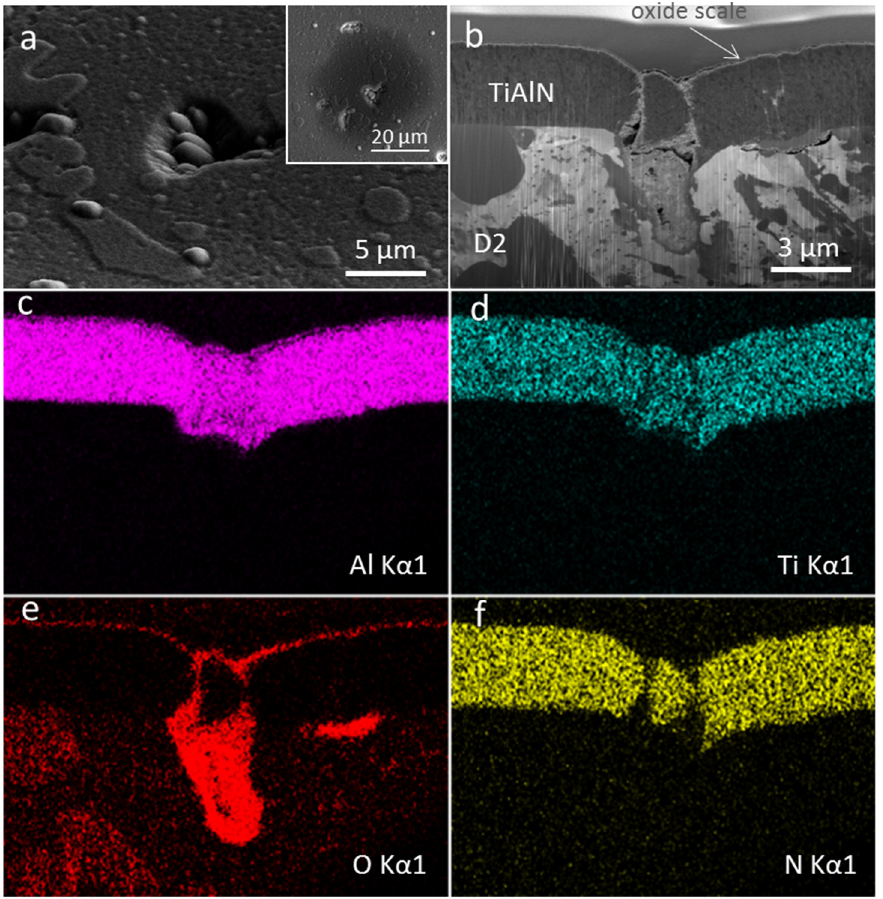
Figure 7. SEM images of pinhole in sputter-deposited TiAlN hard coating oxidized at 800 °C for 60 min: ( a ) SEM images at high and low (inset) magnification, ( b ) SEM image of FIB cross-section of the same defect, and ( c – f ) corresponding elemental maps [43].